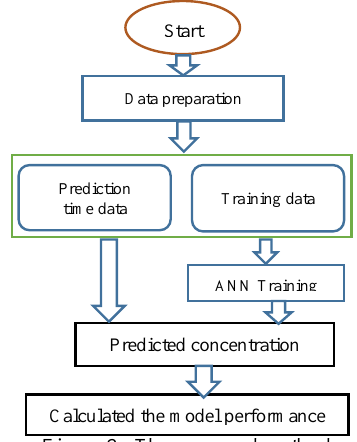
Figure 2. The proposed